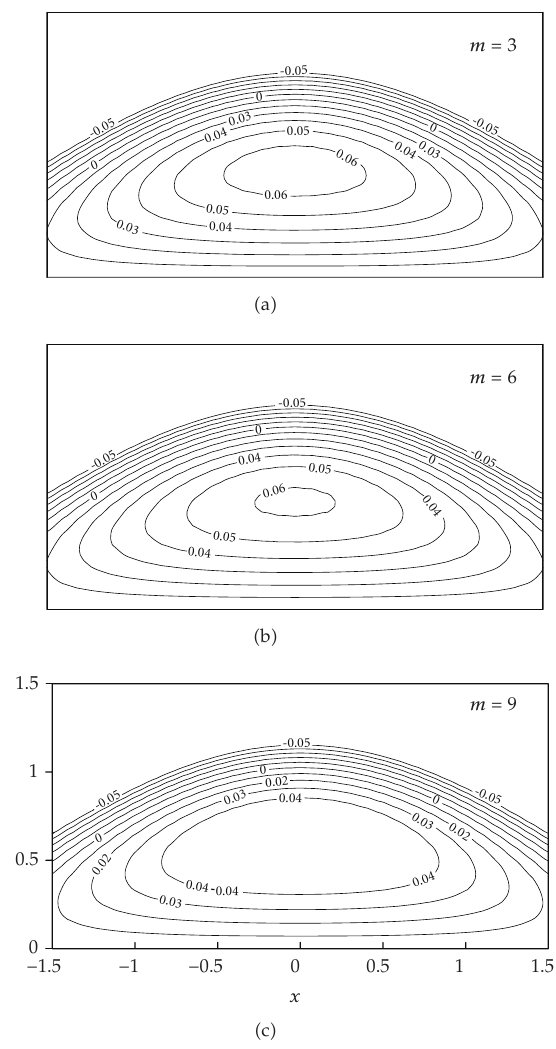
Figure 14: Stream lines for di ff erent values of m